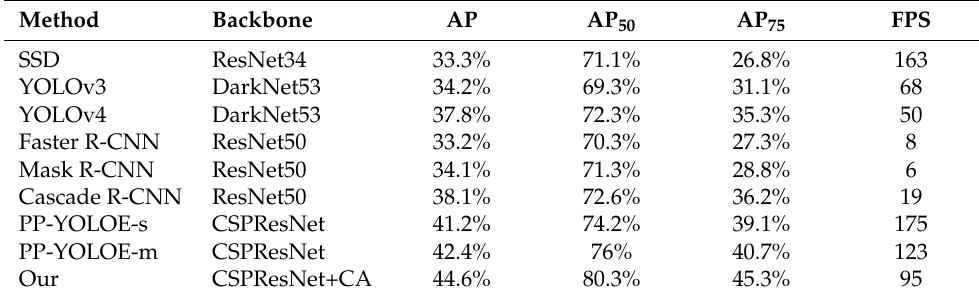
Table 4. Detection results with other methods on the NEU-DET